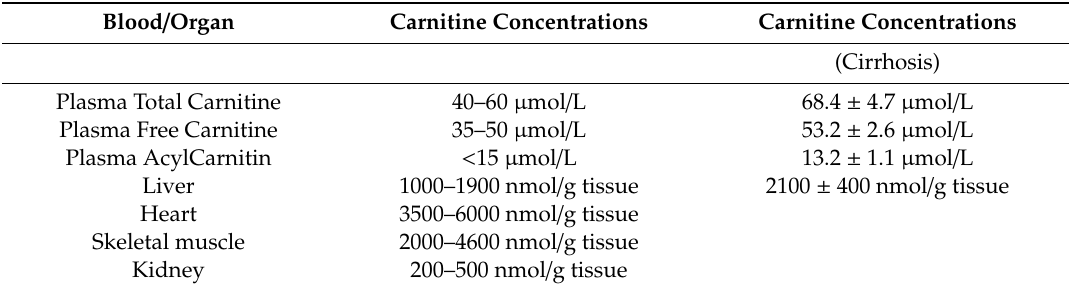
Table 2. Carnitine concentration in human organs and